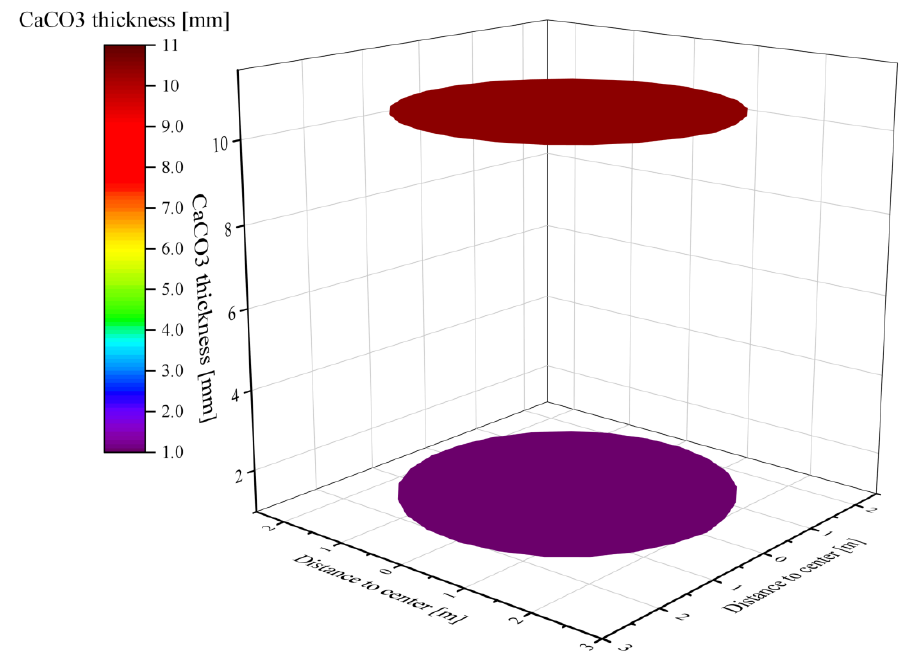
Figure 14. Thickness and distribution of CaCO 3 of 120 mm particles ( up ) and 40 mm particles ( down ) at the outlet of the calcination zone.